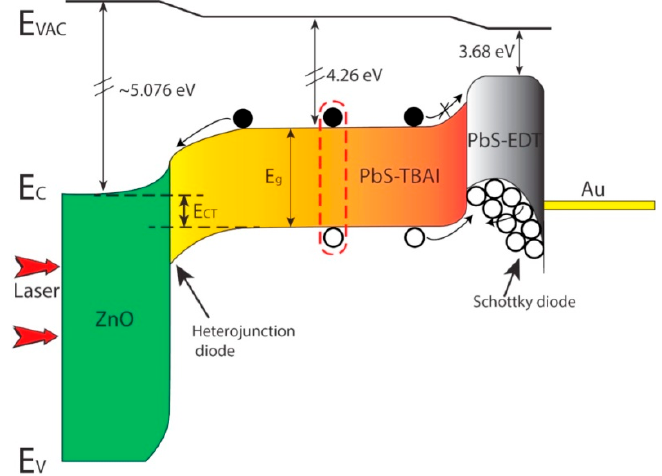
Figure 5. Energy band diagram of a ZnO / PbS-TBAI / PbS-EDT / Au solar cell under illumination, with PbS-EDT working as an electron blocking layer forming a Schottky barrier for holes, thus avoiding their movement to the Au anode. From [66], reprinted with permission. Copyright © Elsevier 2016.